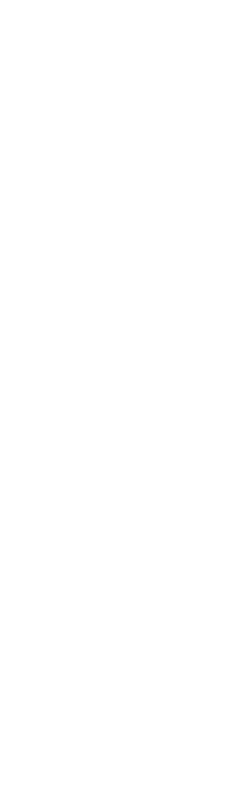
Figure 1 Three potential methods of connecting patients to community- based groups from primary care with examples of how these can be